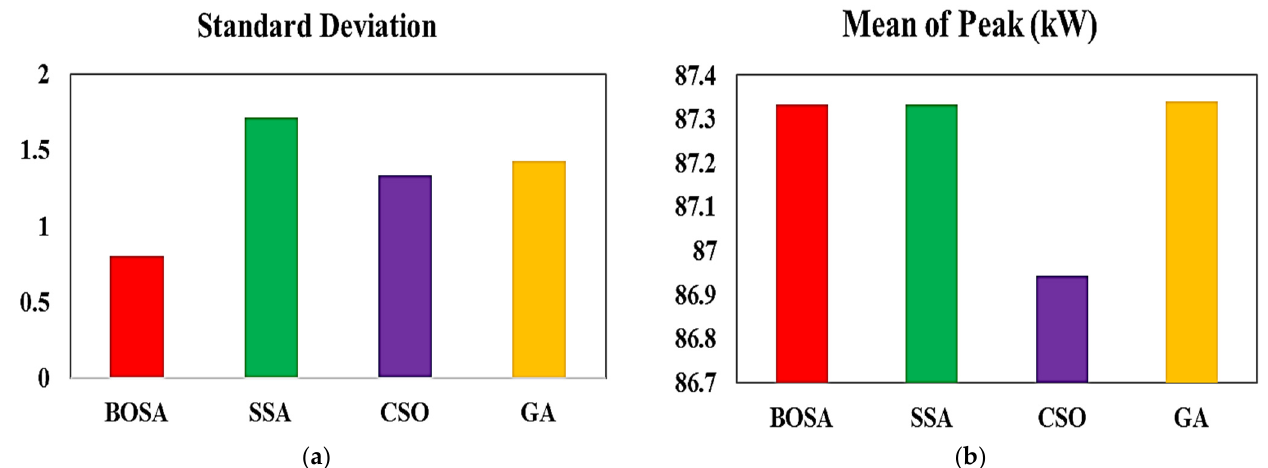
Figure 12. Standard deviation ( a ) and mean of peak values ( b ) using BOSA, SSA, CSO, and GA.